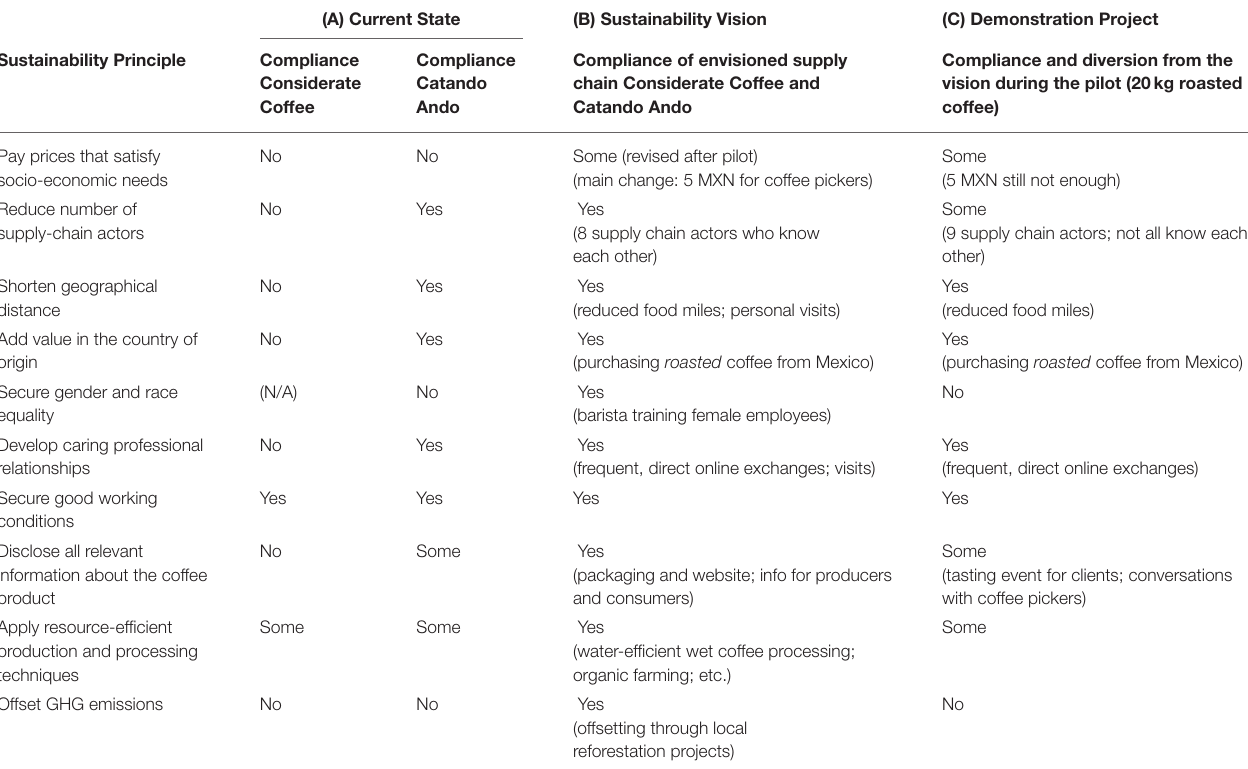
TABLE 4 | Compliance of current state, vision, and demonstration project with sustainability